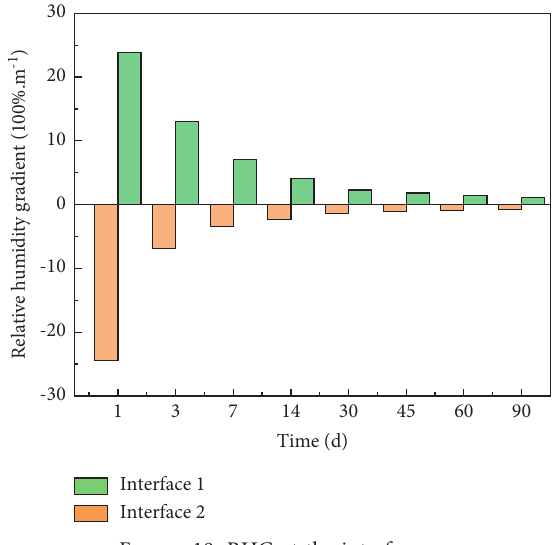
Figure 19: RHG at the interfaces.